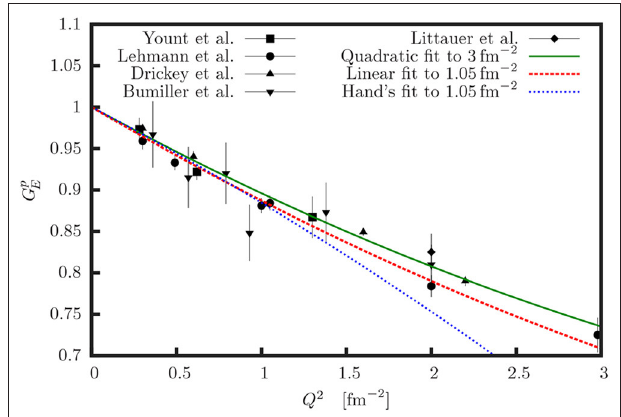
FIGURE 1 | The experimental data [23–27] considered in the analysis. The solid green line shows model (2) when both r E and a are fitted to the data with Q 2 3fm − 2 . The dashed red line shows the results when r E is fitted to the ≤ data with Q 2 1.05fm − 2 , while the parameter a 0.00787fm 4 is kept ≤ = constant. The blue dotted line corresponds to the original result of 0.00787fm 4 . Hand et al. [ 2] assuming a = −